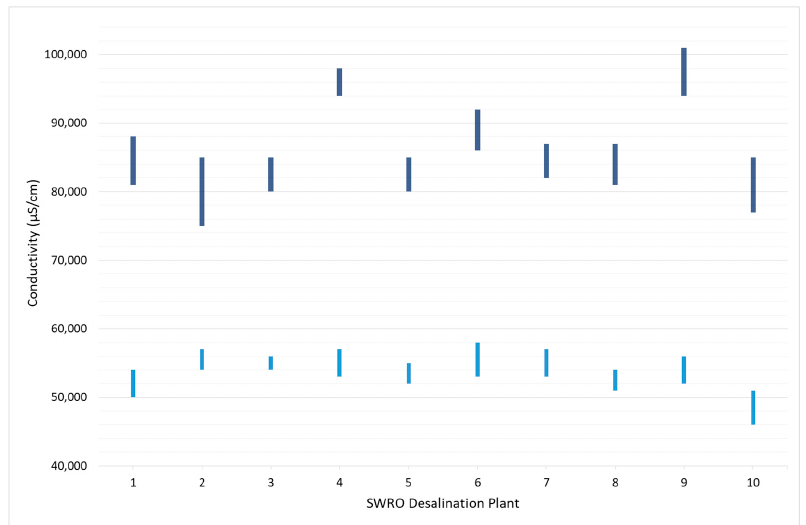
Figure 3. Feed (light blue) and brine (dark blue) conductivities (@25 °C) of the desalination plants included in this study. The average results of the chemical composition analysis of the brine samples are represented in Table 4. The values for each of the 37 parameters analysed are shown, in- cluding the major ions present in the SWRO brine. Table 4. Chemical composition of the brines from 10 desalination plants in the Canary Islands.